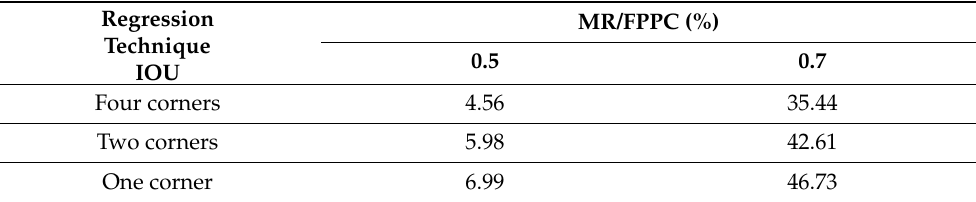
Table 2. Comparisons of different regression methods with respect to bounding box corners.